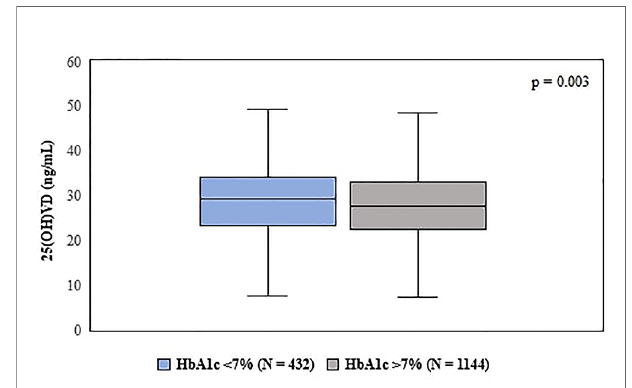
FIGURE 1 | Comparison of vitamin D levels according to patient ’ s HbA1c range. Statistical test used: Mann – Whitney U test.